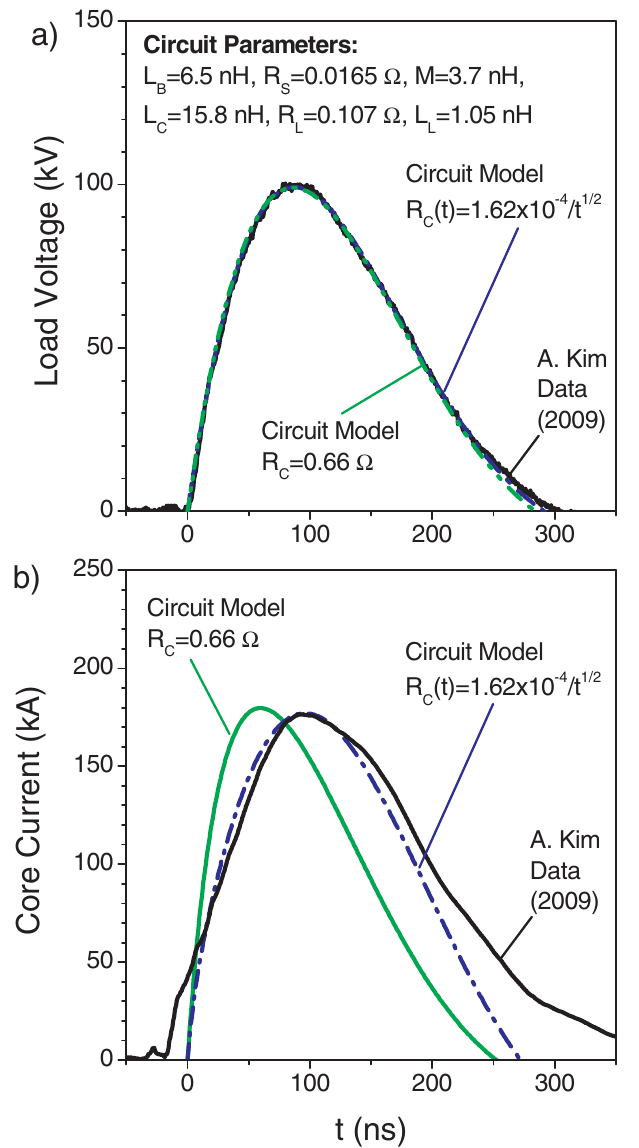
FIG. 9. (Color) Comparison of (a) load voltages and (b) core currents. The black curves are the measured signals from Kim et al. [5]. The blue curves are from circuit calculations with ð t Þ as given by Eq. (1). The green curves are from circuit R C calculation with R C ¼ 0 : 66 (cid:2)